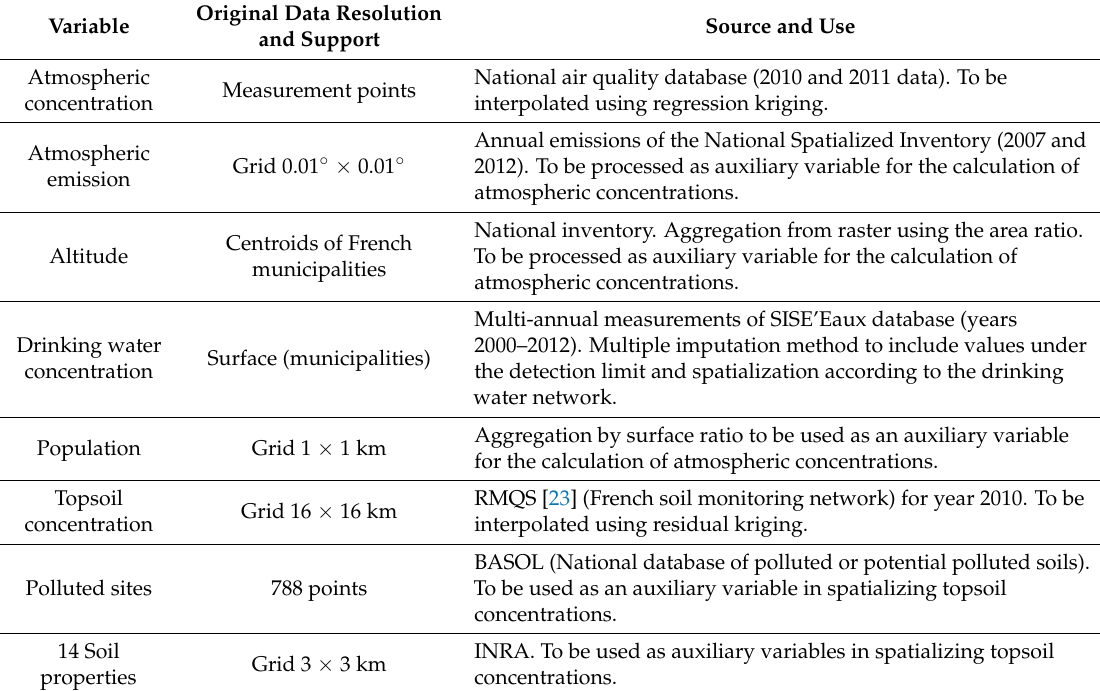
Table 1. Available data and